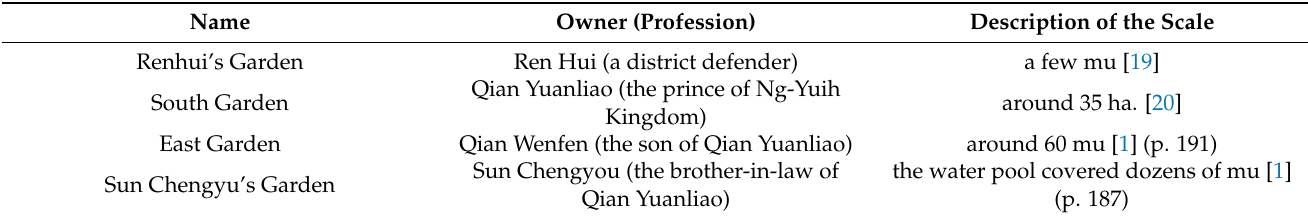
Table 1. Recorded scales of Suzhou private gardens from 7th to 10th century.